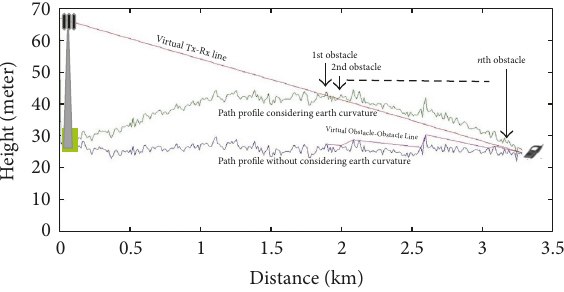
Figure 11: Path profile and earth curvature